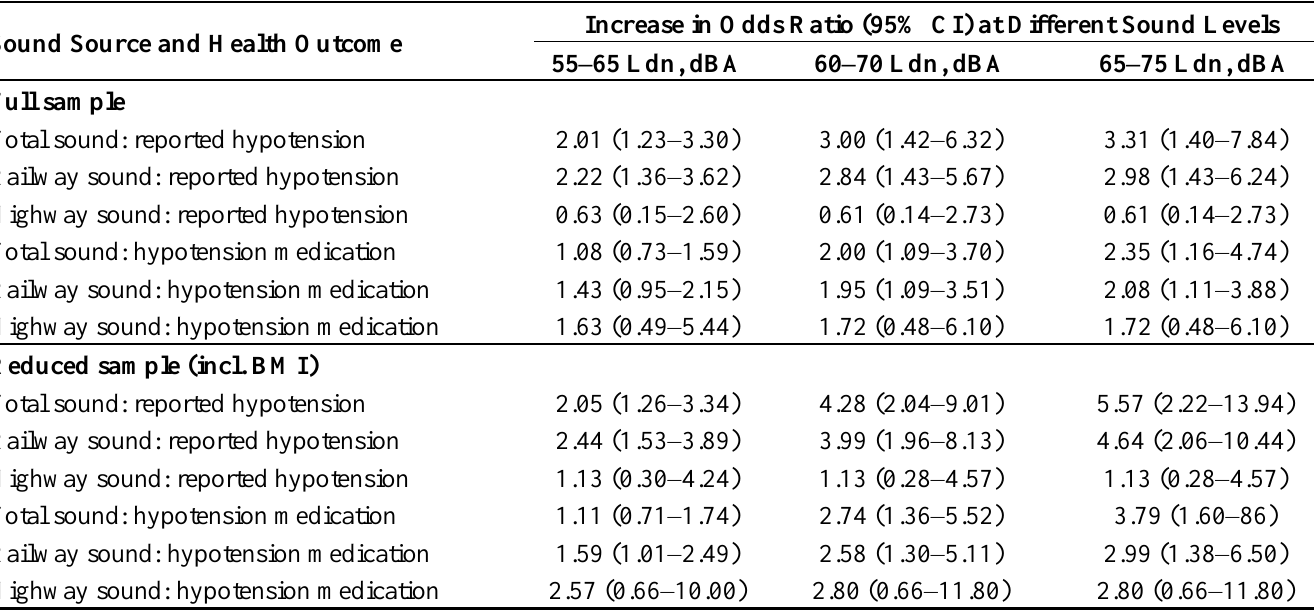
Table 5. A summary of the increase in the odds ratio (95% CI) at different sound levels in all adjusted